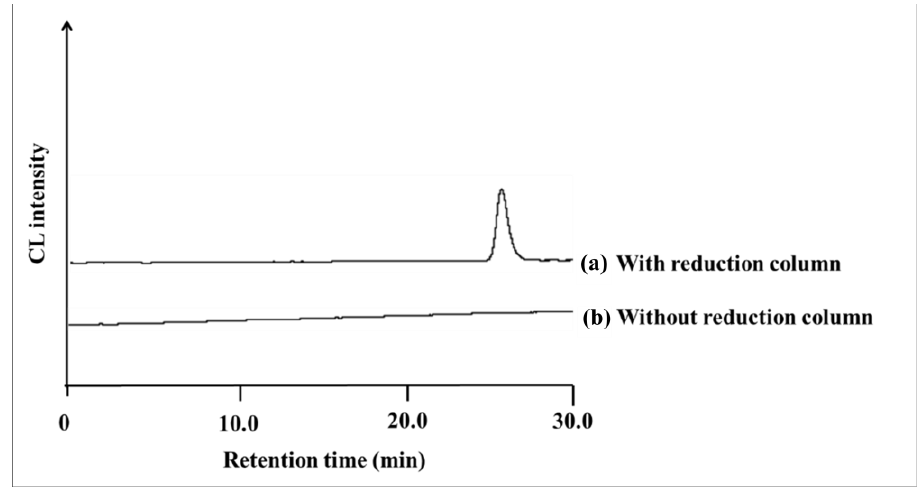
Figure 3. Chromatograms of 1.0 μM UQ standard obtained ( a ) with electrolytic reduction and ( b ) without electrolytic reduction by HPLC-CL detection. Figure 6. Chromatograms of 1.0 μM UQ standard obtained ( a ) with reduction column and ( b ) with- out reduction column by HPLC-CL detection.